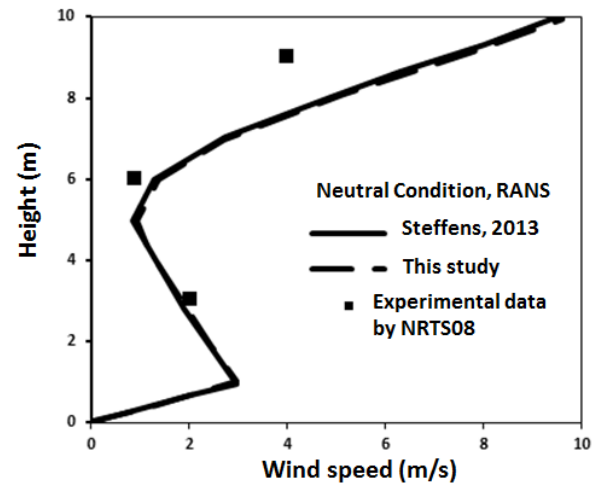
Figure 3. Vertical velocity distribution comparison at 24 m downwind from inlet.